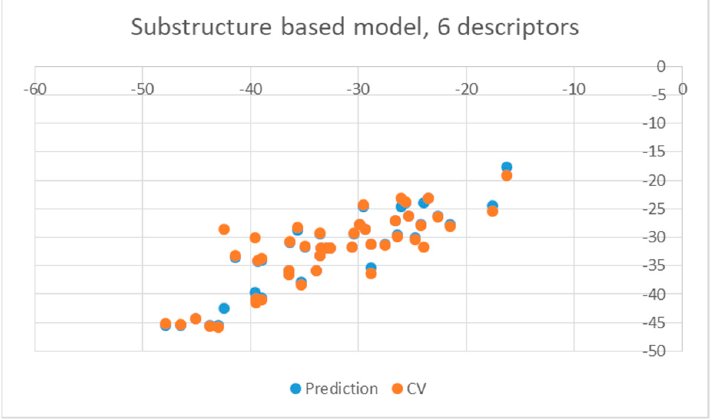
Figure 6. Obtained substructure-based QSAR results obtained with six descriptors for mutants.